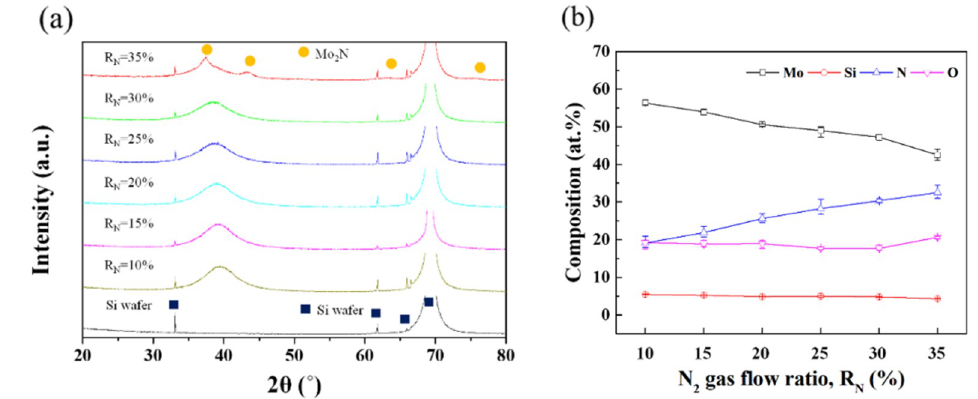
Figure 1. ( a ) X-ray diffractometry (XRD) patterns and ( b ) chemical composition of the Mo–Si–N coatings fabricated by diverse N 2 gas flow ratios from 10% to 35%, retaining the working pressure of 10 mTorr.